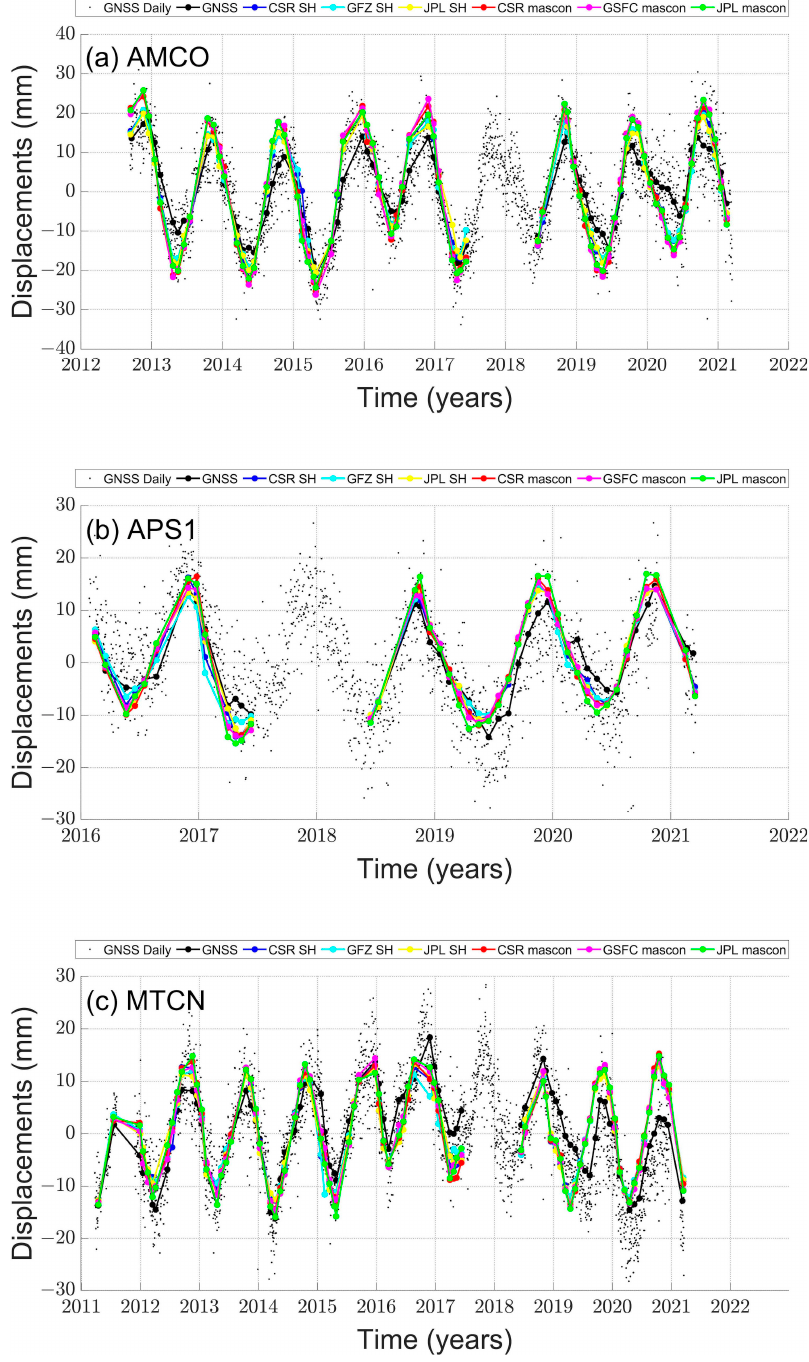
Figure 7. Time series at three specific GNSS stations: ( a ) AMCO, ( b ) APS1, and ( c ) MTCN.